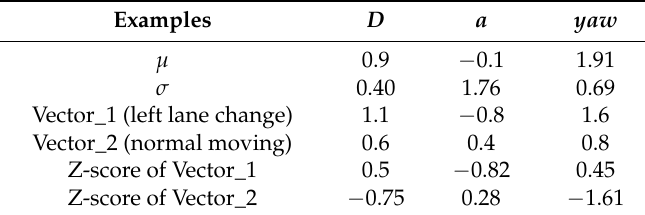
Table 1. Means and standard deviations of feature vectors and two feature vector samples.